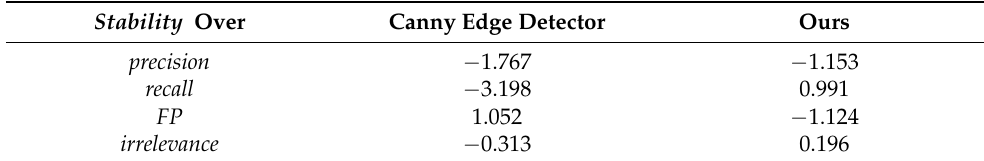
Table 6. Quantitative comparisons on stability for edge detection method (with image preprocessing) and ours under varied foggy